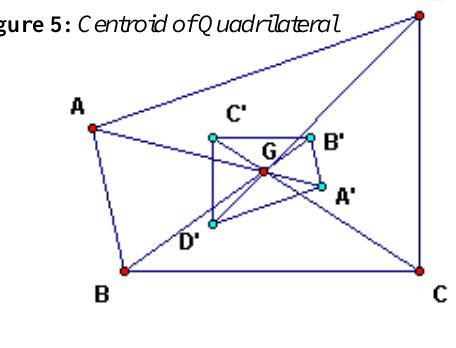
Figure 5: Centroid of